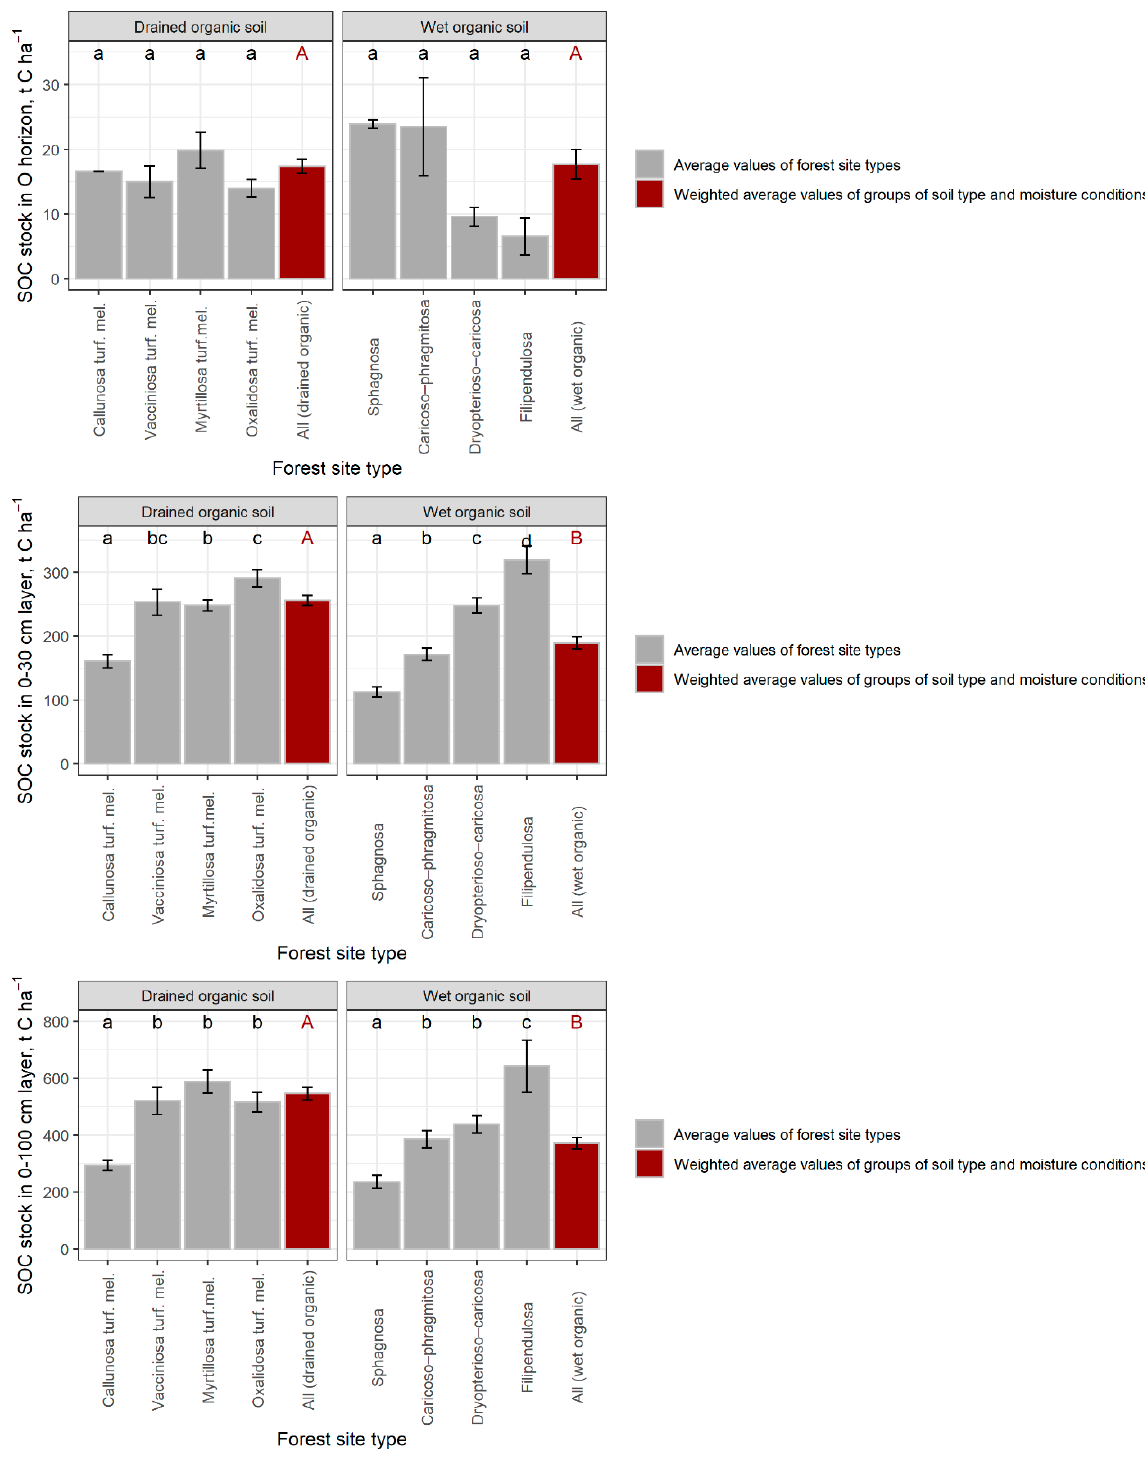
Figure 6. SOC stock per unit area in the O horizon, in the 0–30 cm layer and in the 0–100 cm layer in forest land with organic soils in Latvia. The division into groups of soil moisture conditions is based on forest site type according to the national forest classification. Error bars represent standard errors. Different lower-case letters (black) show statistically significant differences ( p < 0.05, α = 0.05) in average values between forest site types within a group of soil type and moisture conditions; different upper-case letters (red) show statistically significant differences ( p < 0.05, α = 0.05) in weighted average values between different groups of soil type and moisture conditions. In the 0–30 cm layer, the forest site type average SOC stock ranged up to 319.7 ± 21.9 t C ha − 1 (in Filipendulosa stands), while the weighted average SOC stock in the 0–30 cm